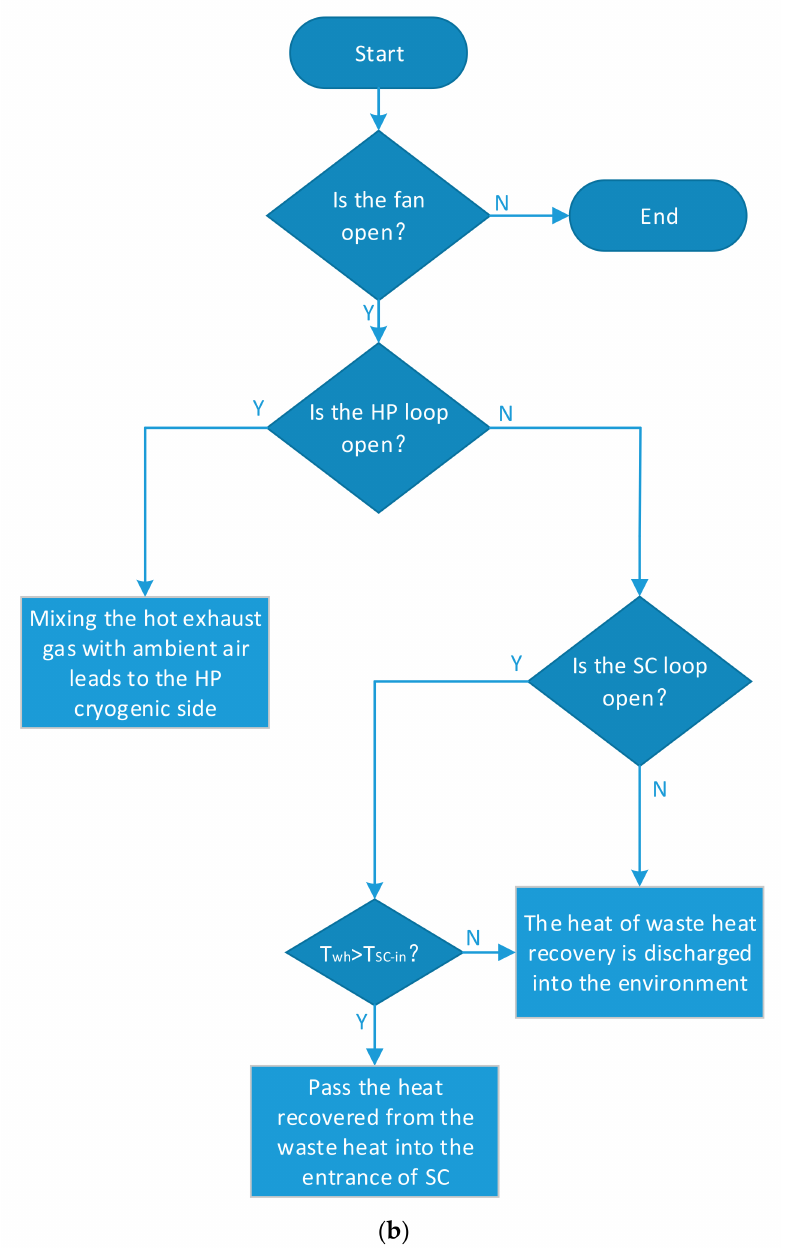
Figure 2. ( a ) SCAHP operation logic, part 1: the control logic of SCAHP except for the waste heat recovery module. ( b ) SCAHP operation logic, part 2: the control logic of the waste heat recovery